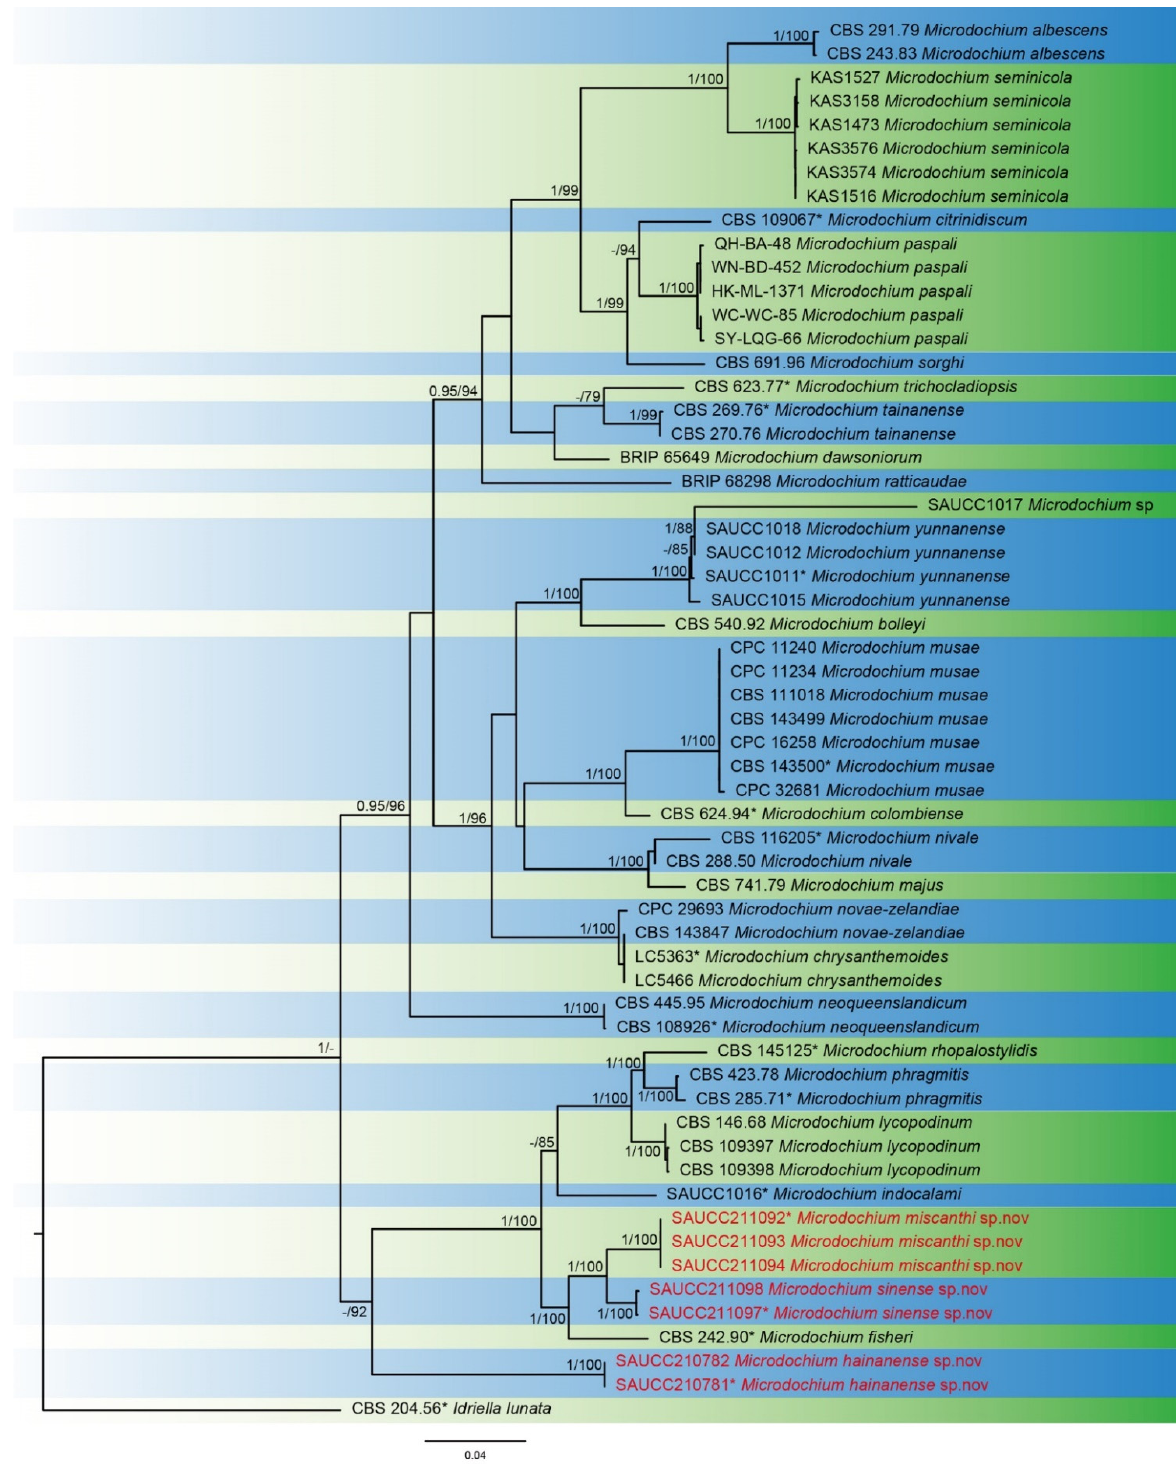
Figure 1. A maximum-likelihood phylogram of Microdochium based on combined ITS, LSU, TUB2 and RPB2 sequences with CBS 204.56 of Idriella lunata as outgroup. The maximum-likelihood Bootstrap Value (MLBV ≥ 75%) and Bayesian Inference Posterior Probability (BIPP ≥ 0.95) are shown at the first and second position, respectively. Strains marked with “*” are ex-types, ex-epitypes or holotypes. Strains from the current study are in red. The scale bar at the bottom middle indicates 0.08 substitutions per